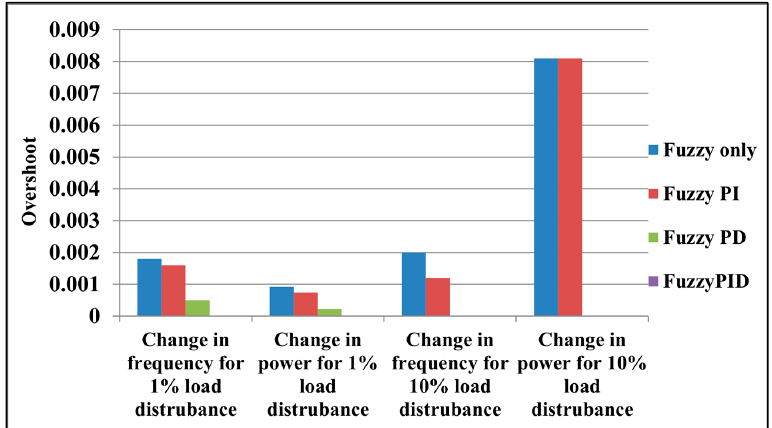
Figure 19. Comparison of dynamic responses of the hybrid system in terms of Overshoot (p.u) for frequency and power of the hybrid system with Fuzzy, Fuzzy-‘PI’, Fuzzy-‘PD’ and Fuzzy-‘PID’ against different load disturbances.